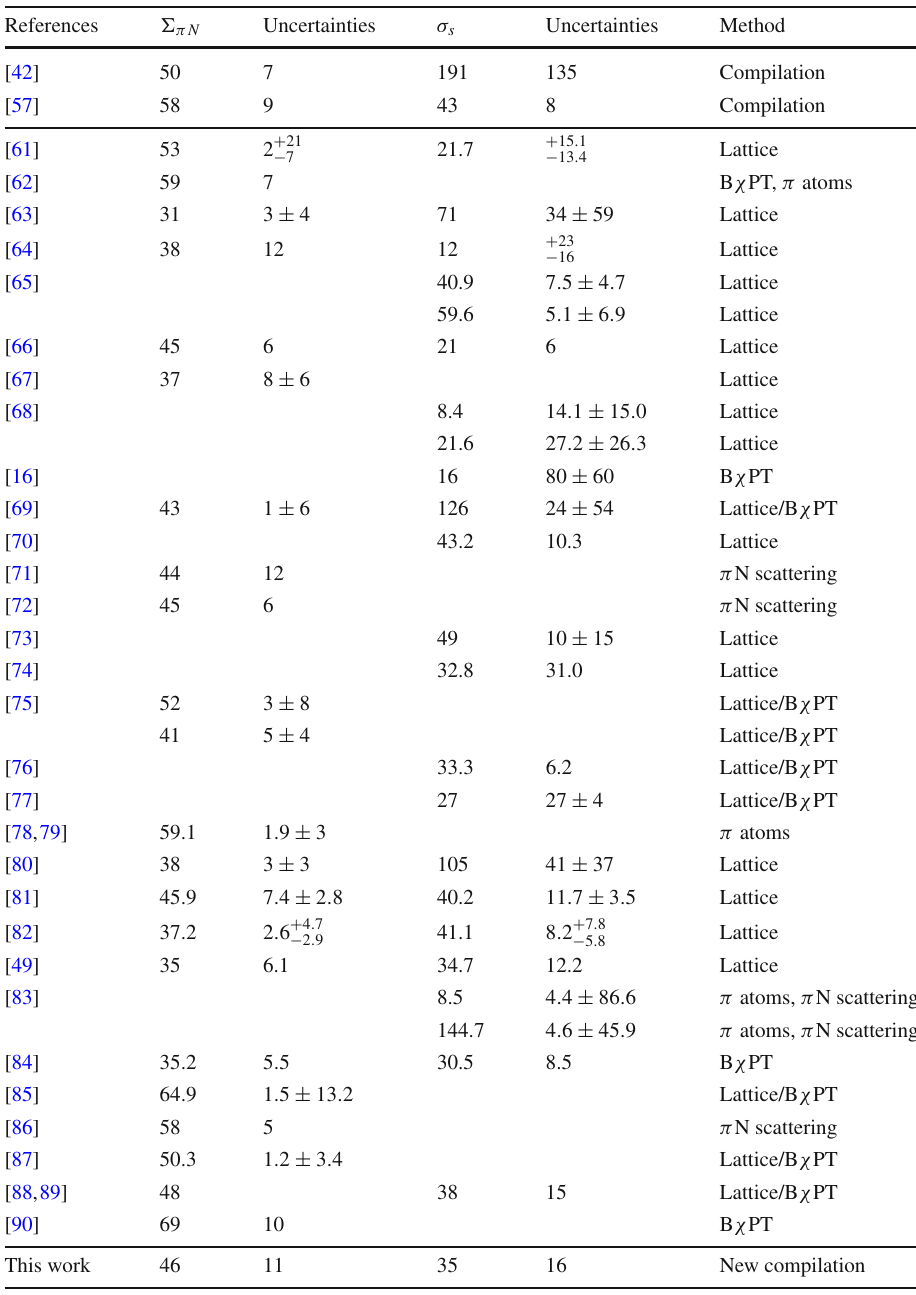
Table 1 Estimates of (cid:7) π N and